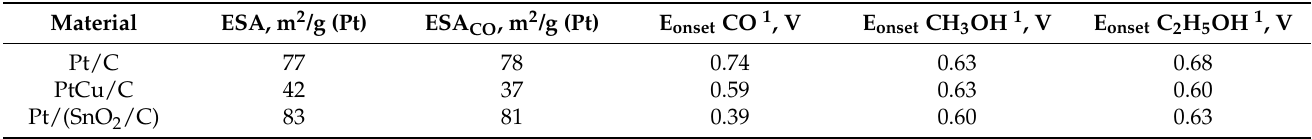
Figure 3. Cyclic voltammograms of samples: ( a ) After surface standardization and ( b ) after CO transmission at potential 0.10 V. Electrolyte is 0.1 M HClO 4 , Ar atmosphere. The potential sweep rate is 20 mV s −1 . Table 2. Values of electrochemically active surface (ESA) and onset potentials of CO, CH 3 OH, and C 2 H 5 OH oxidation for the studied